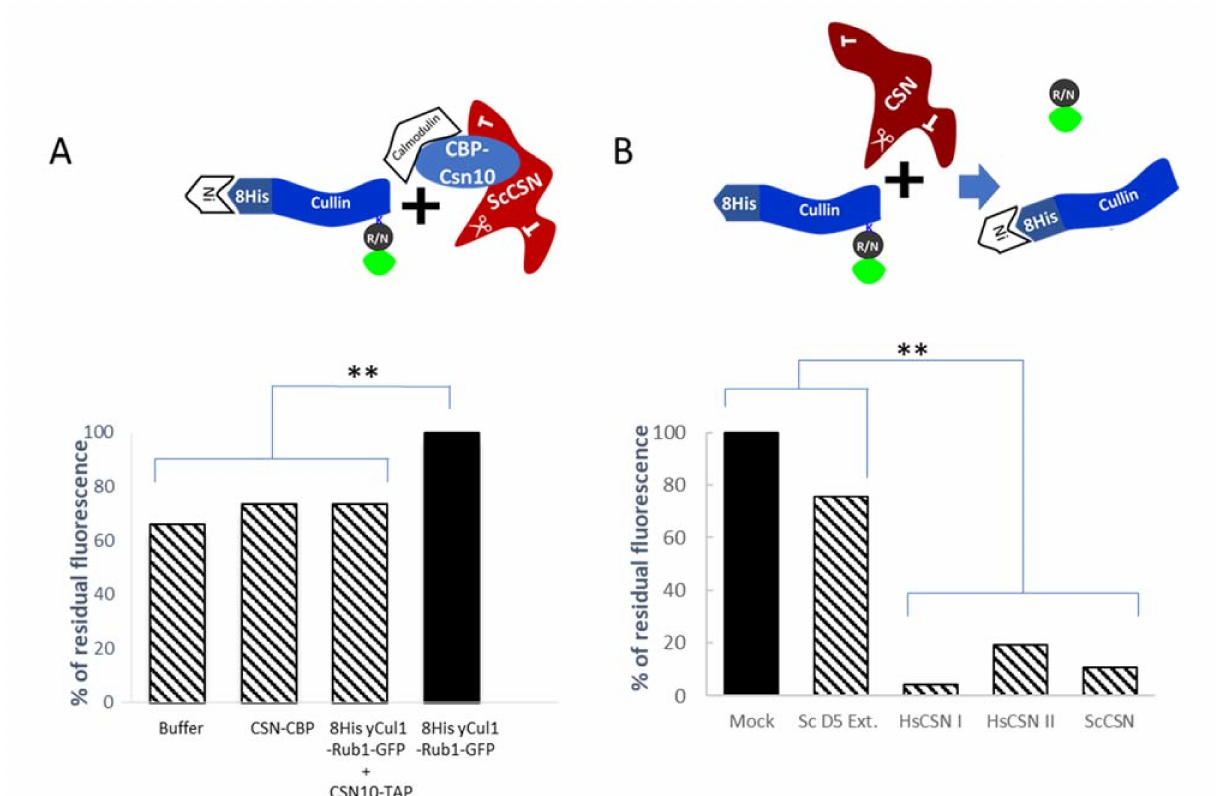
Figure 4. Using the S. cerevisiae fluorescent substrate to evaluate human CSN activity. ( A ) Ni-NTA resin (Ni)-attached substrate (8His-yCul1-GFP-Rub1) was mixed with calmodulin resin attached to CBP-Csn10 CSN complexes ( Sc CSN) for 20 min before evaluating the fluorescent readout. Readout of the buffer, or substrate-free CSN resin were used as controls. The residual fluorescent of the substrate in the CSN-included assay (lane 3) is compared to the total fluorescence in the enzyme-free experiment (lane 4). ( B ) Crude extract of ∆ csn5 ∆ rub1 cells expressing 8His-yCul1-Rub1-GFP exposed to purified human CSN from individual purification events (CSN I, CSN II) and to wildtype S. cerevisiae extract ( Sc CSN) for 30 min at 30 ◦ C. Following the assay, the substrate was linked to Ni-NTA resin and fluorescent readout was evaluated, compared with controls (in black): Substrate treated by buffer (mock), or with ∆ csn5 yeast extracts (Sc D5 ext.). Results were statistically verified by one-way ANOVA followed by Tukey HSD Test ( n > 3). ** represents p <